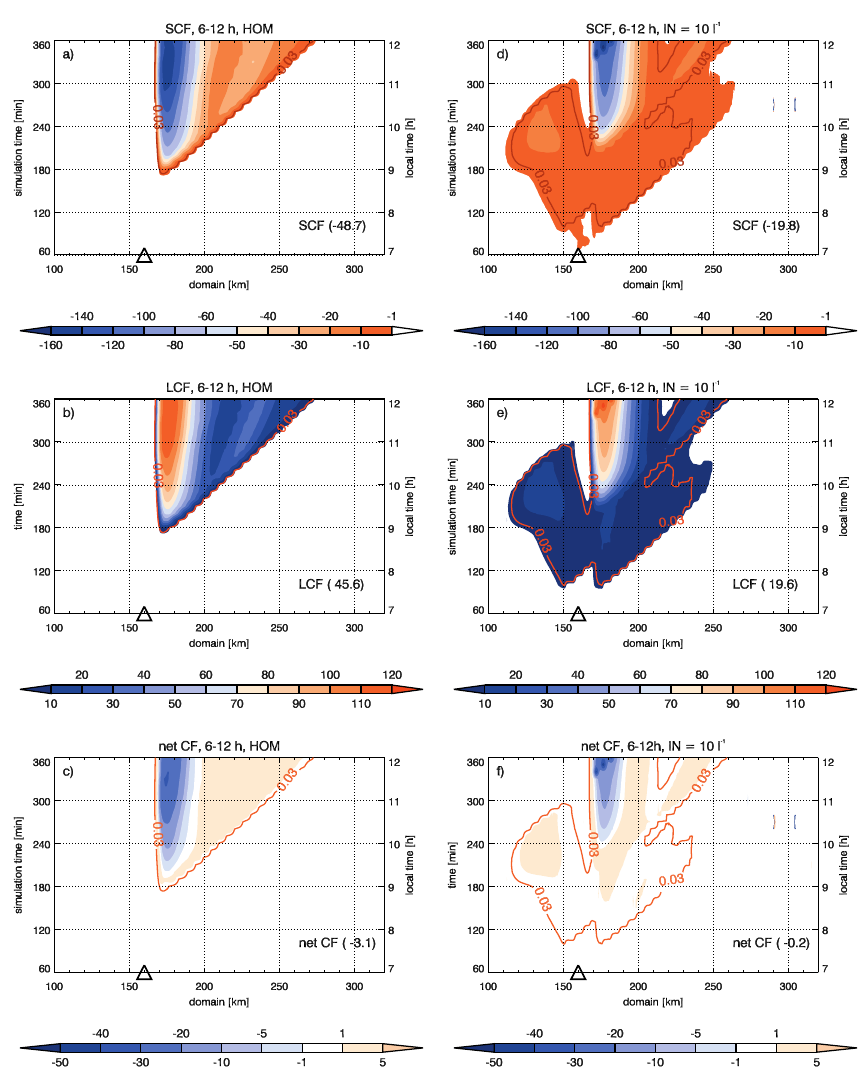
Figure 5. Time evolution of (a, d) shortwave cloud forcing (SCF), (b, e) longwave cloud forcing (LCF) and (c, f) net cloud forcing (NCF) for simulation HOM (left column) and 10 IN (right column) for the reference temperature profile from 06:00 to 12:00LT. The red line shows where τ = 0.03 and the triangle denotes the position of the top of the mountain. The numbers in brackets show the mean values; the mean is only calculated where τ > 0 . 03. Note that the time of the day is specified for these simulations with